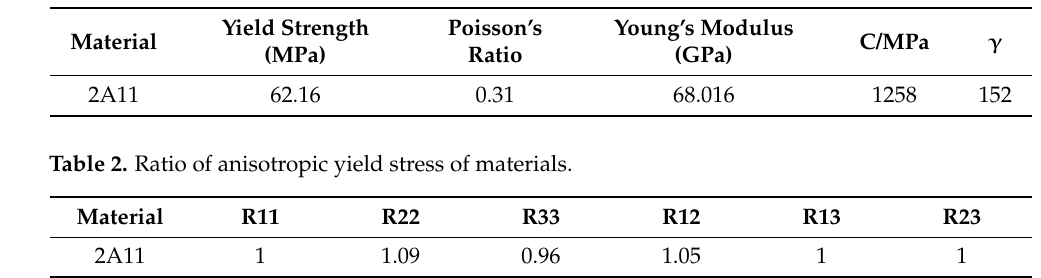
Figure 3. ( a ) True stress–strain curve of 2A11 aluminum alloy sheet; ( b ) anisotropy coefficient of 2A11 aluminum alloy sheet. Table 1. Simulation of material parameters required.